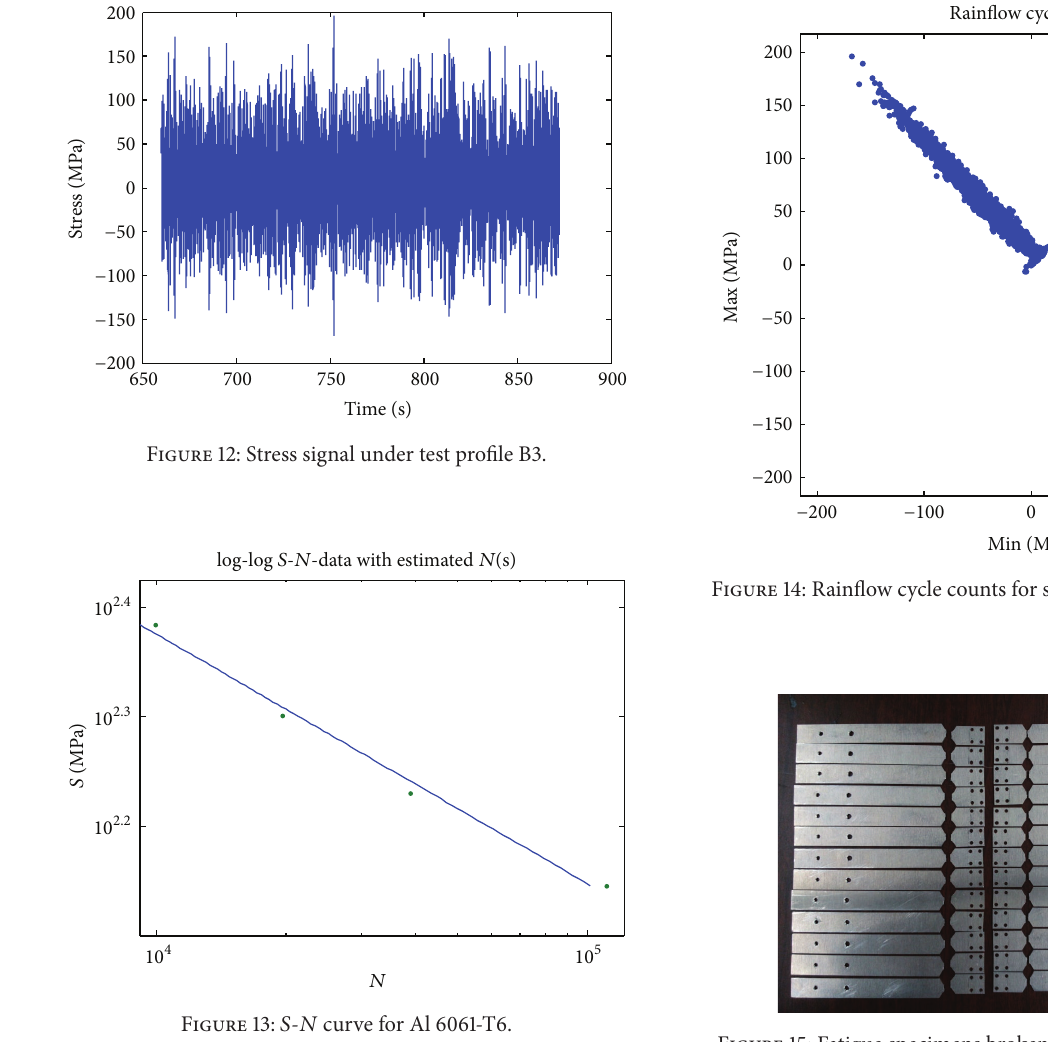
Figure 15: Fatigue specimens broken during this